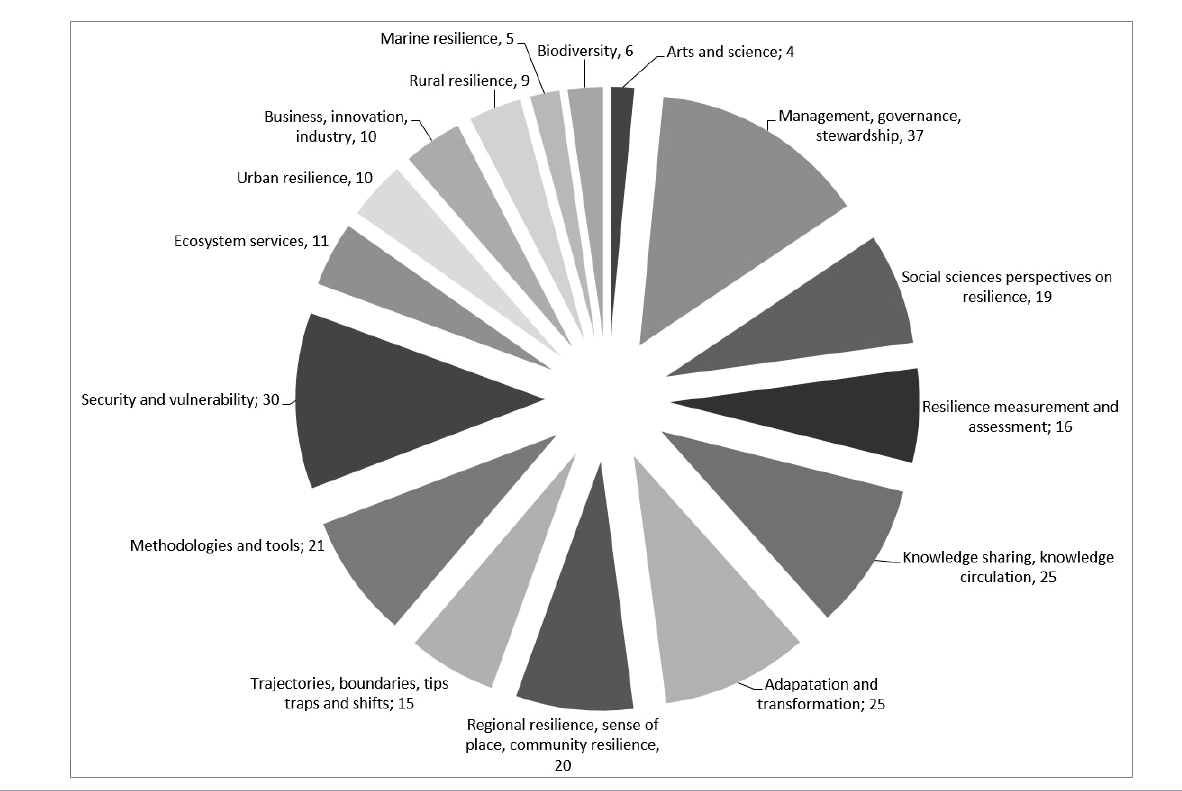
Fig. 1 . Topics of the Resilience 2014 Conference session. Numbers represent the numbers of sessions per category. Group sessions on security and vulnerability include sessions on food security and resilience to natural